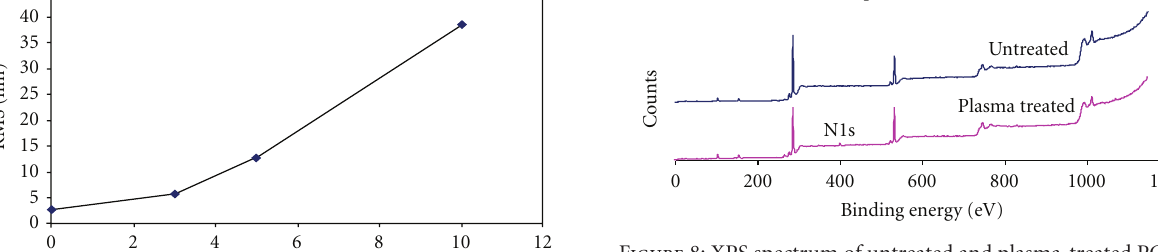
Figure 8: XPS spectrum of untreated and plasma-treated PC